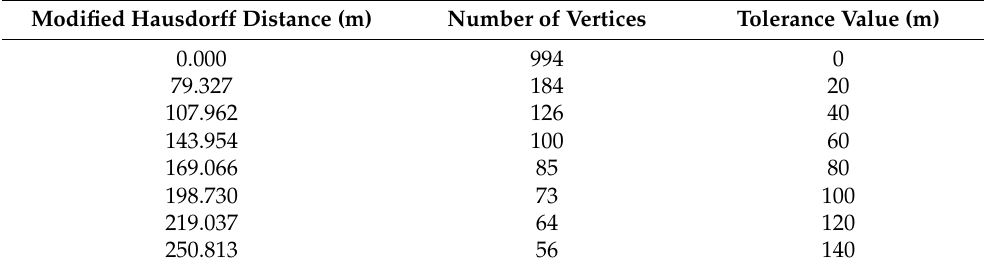
Table 3. Computation of modified Hausdorff distances per tolerance value (line